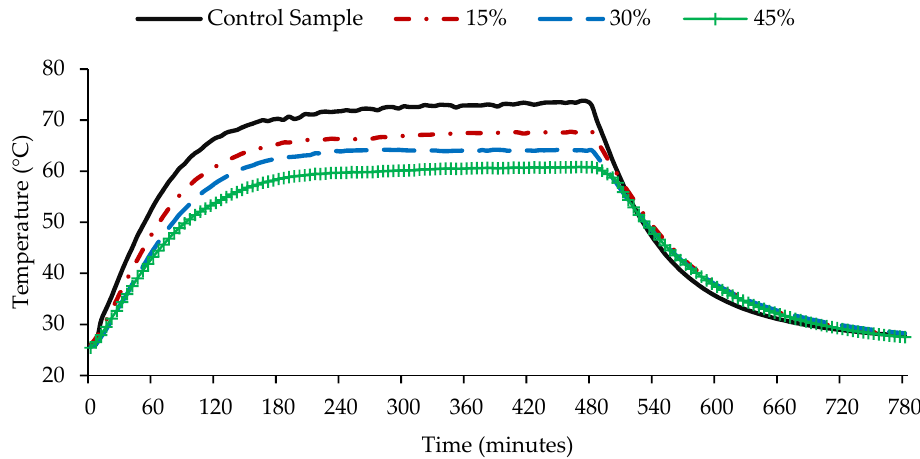
Figure 6. Comparison of the temperatures on one-side for 15%, 30%, 45% with the control sample. Table 2. Steady-state temperatures at different surfaces for all the samples.